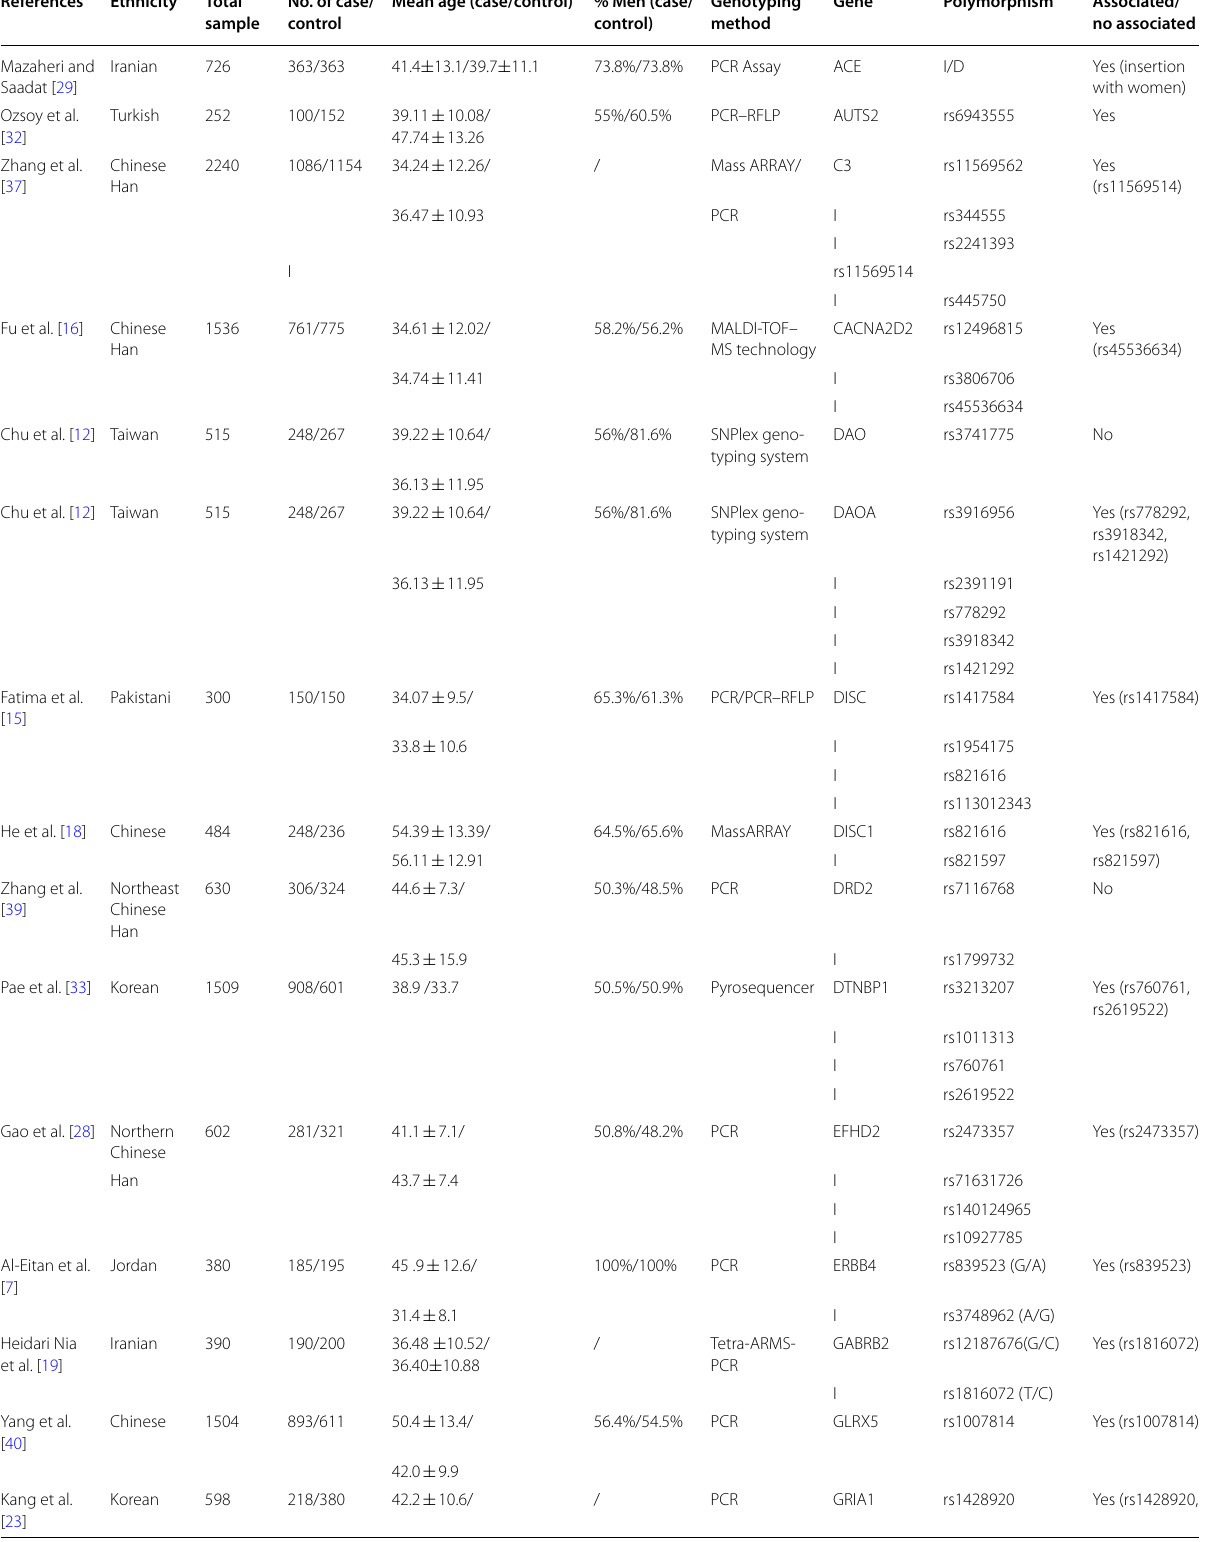
Table 2 The genetic polymorphisms implicated in schizophrenia included in this